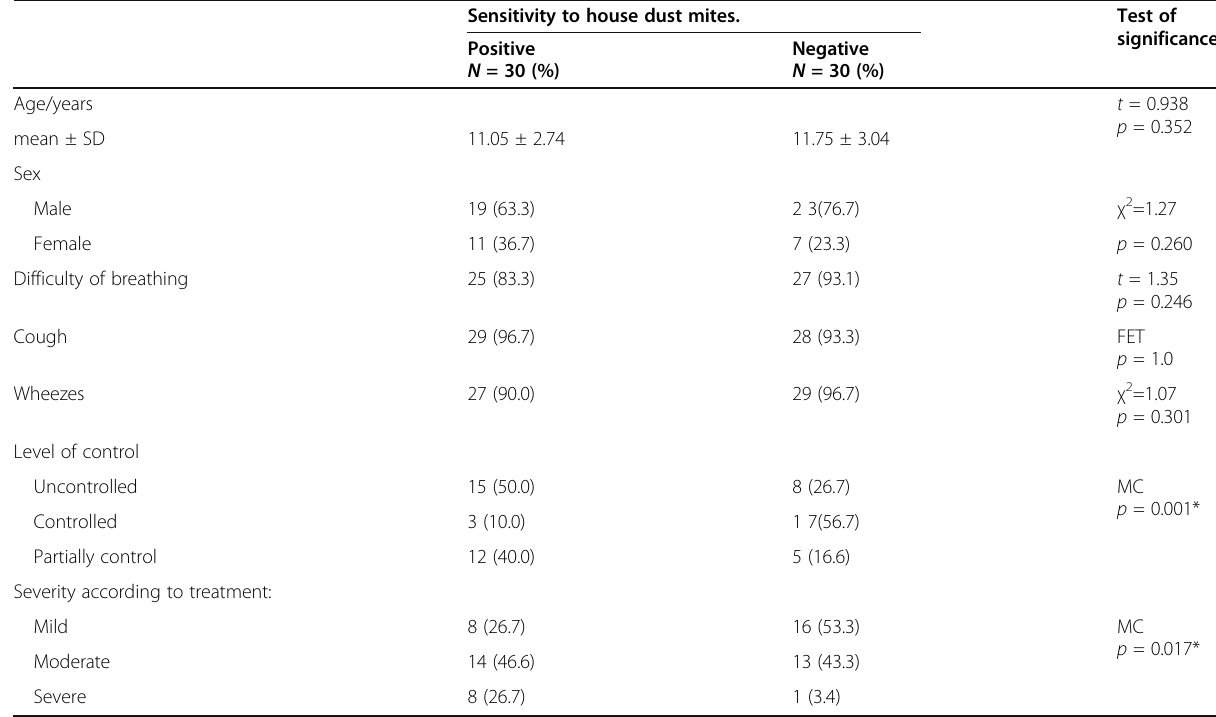
Table 1 Clinical and demographic characteristics among studied cases Sensitivity to house dust